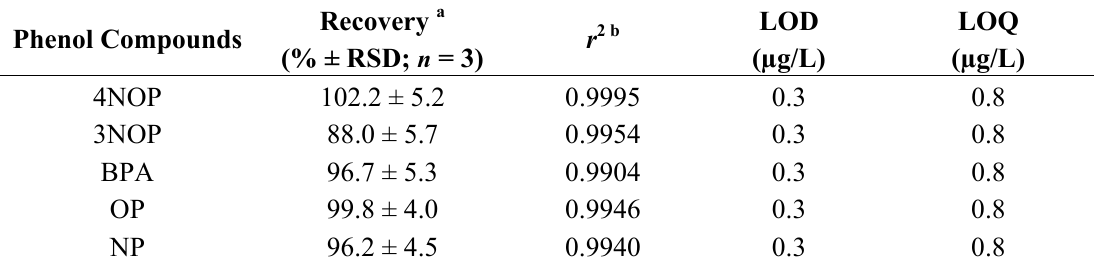
Table 1. Recovery yields, determination coefficients ( r 2 ), LODs and LOQs achieved for five phenol compounds in ultrapure water samples using BAµE(PS-DVB)-LD/HPLC-DAD analysis, under optimized experimental